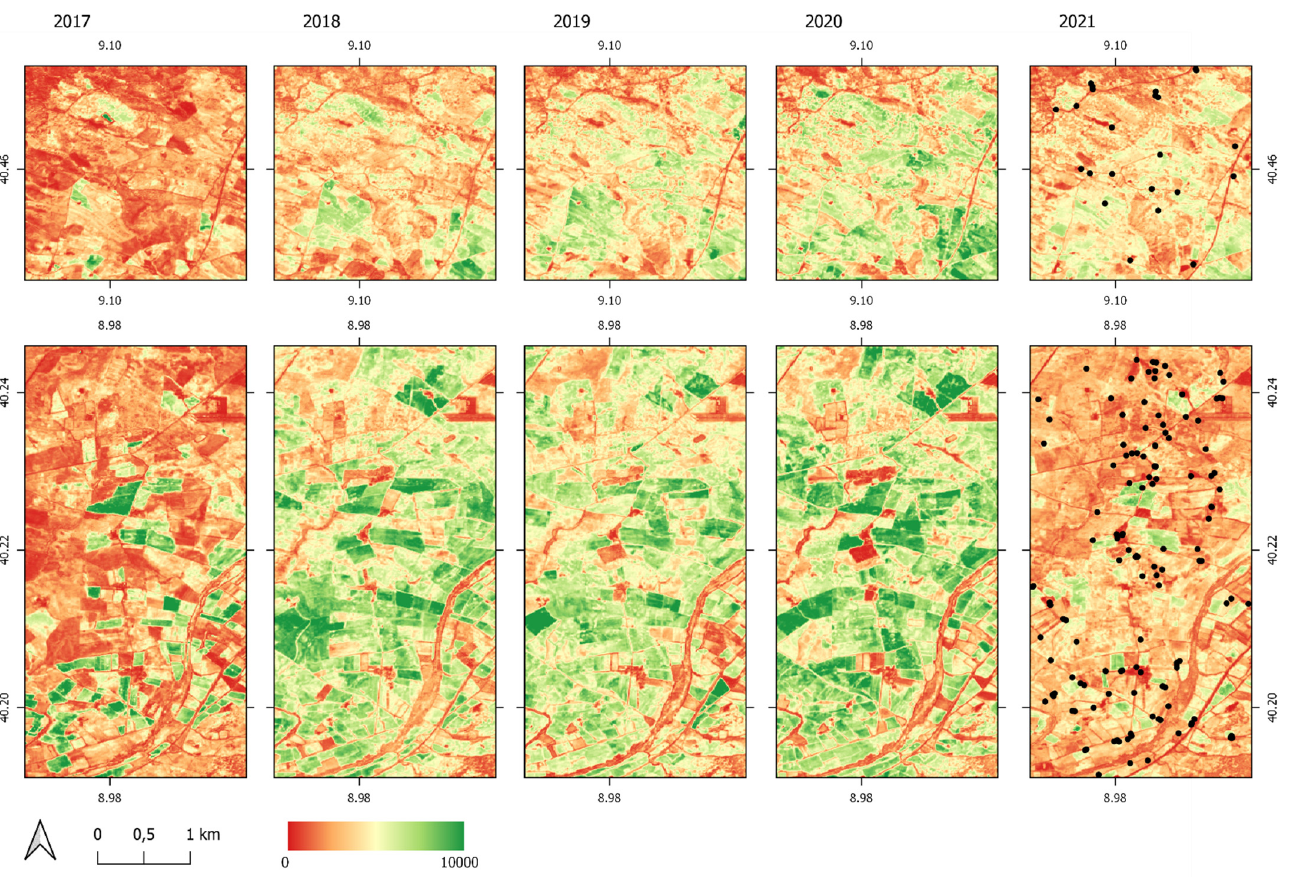
Figure 4. NDVI variance for vegetative period (Mar–Nov) for 2017–2021 as an indicator for agricul- tural activities. Zoom in to both regions with high density of DMA locations in 2022 (compare 2.2). Black dots = recorded DMA locations in 2022.